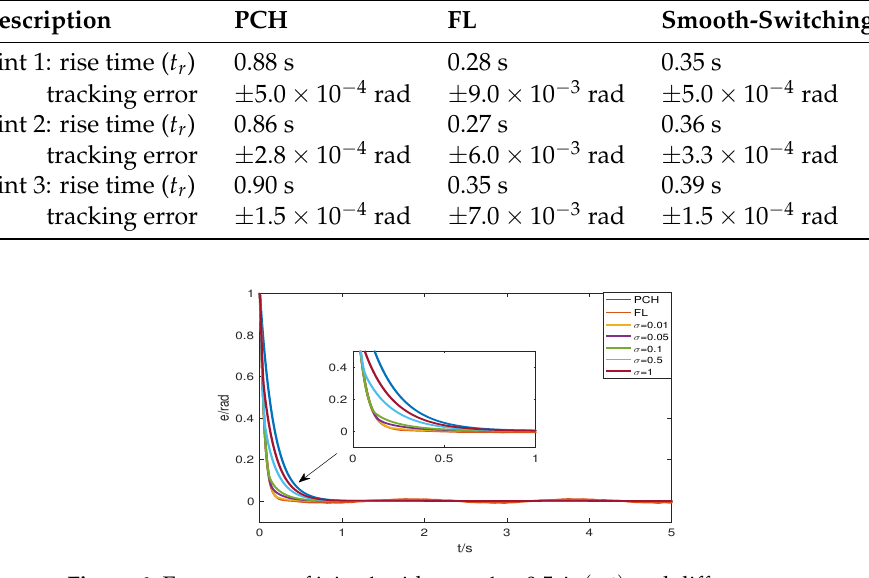
Figure 6. Error curves of joint 1 with q d = 1 + 0.5sin ( π t ) and different σ .